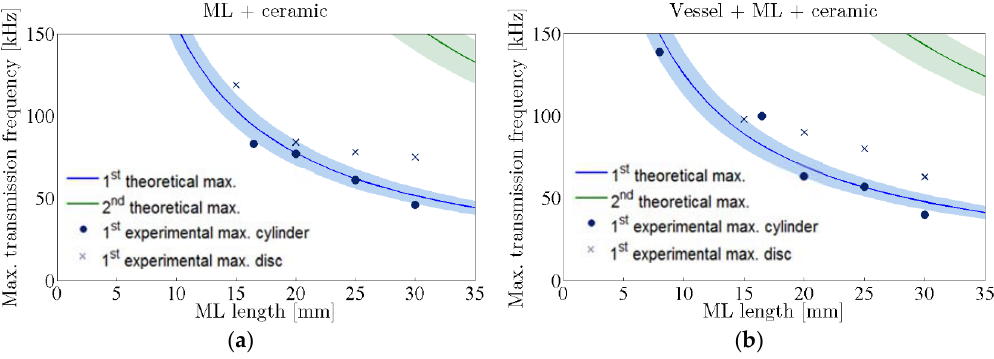
Figure 15. Frequency of maximum sound transmission vs. thickness of the aluminum ML for the models of transmission for one layer ( a ) and two layers ( b ), compared to the measured data in configurations 1 and 2, respectively.